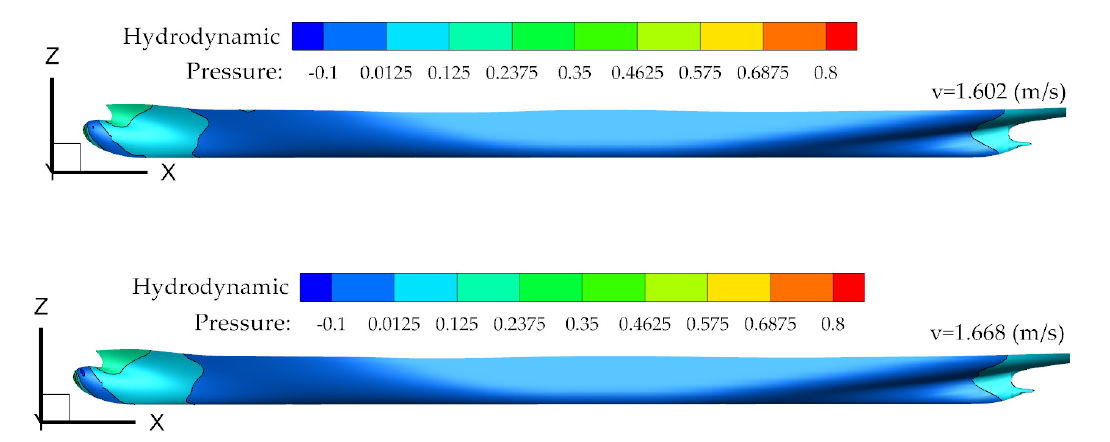
Figure 11. Hydrodynamic pressure (N/m 2 ) for all speeds (Tecplot).